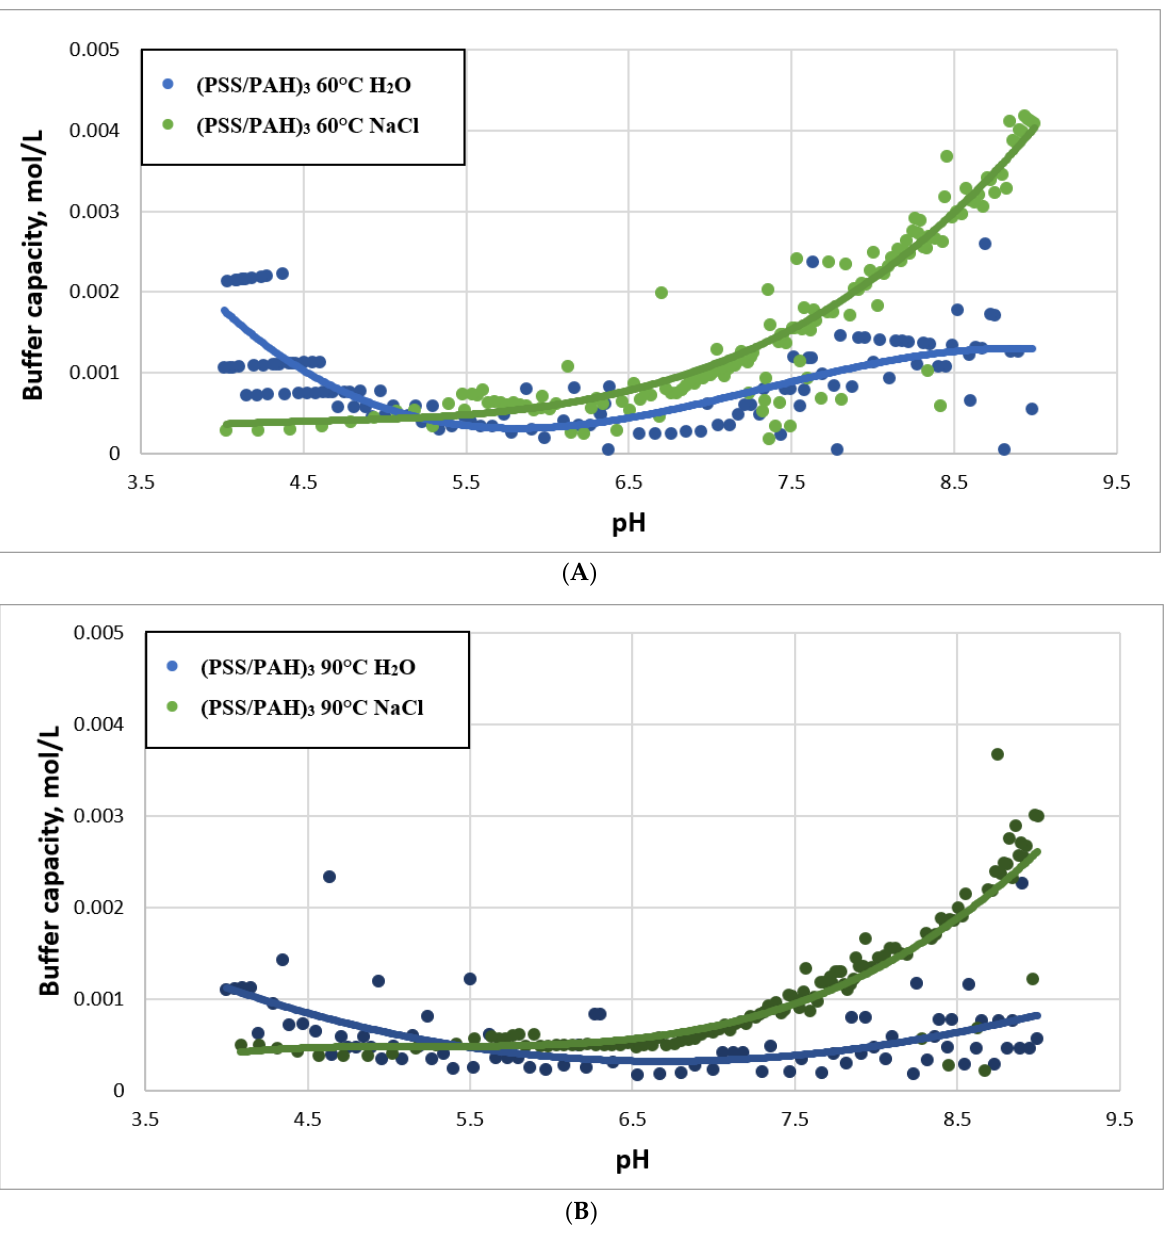
Figure 4. Buffer capacity of PMC composition (PSS/PAH) 3 in water and in 1 M NaCl solution after incubation at 60 °C ( A ) and 90 °C ( B ).